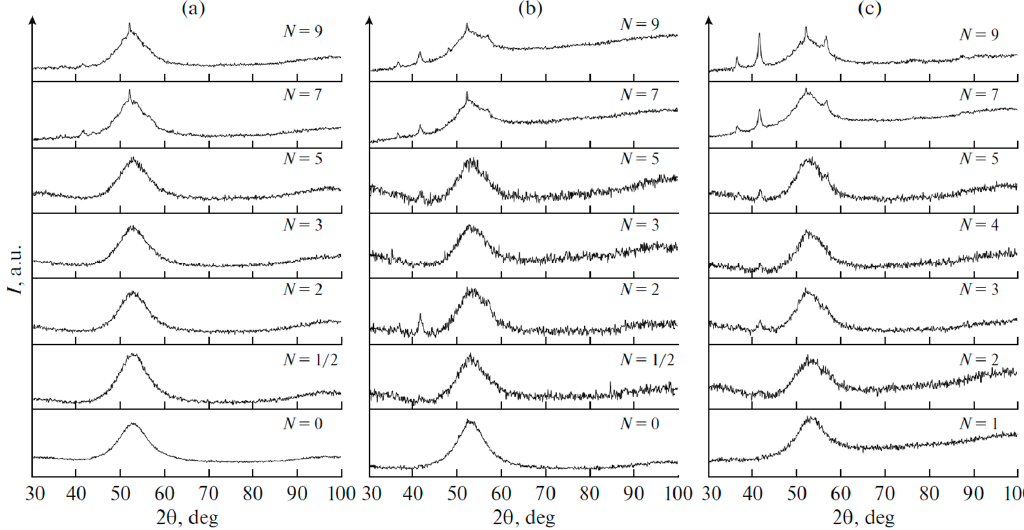
Figure 2. X-ray diffraction (XRD) patterns of multilayer AA samples subjected to high-pressure Figure 2. X-ray di ff raction (XRD) patterns of multilayer AA samples subjected to high-pressure torsion torsion (HPT): ( a ) Fe 53.3 Ni 26.5 B 20.2 , ( b ) Co 28.2 Fe 38.9 С r 15.4 Si 0.3 B 17.2 and ( c ) composite material. (HPT): ( a ) Fe 53.3 Ni 26.5 B 20.2 , ( b ) Co 28.2 Fe 38.9 Cr 15.4 Si 0.3 B 17.2 and ( c ) composite